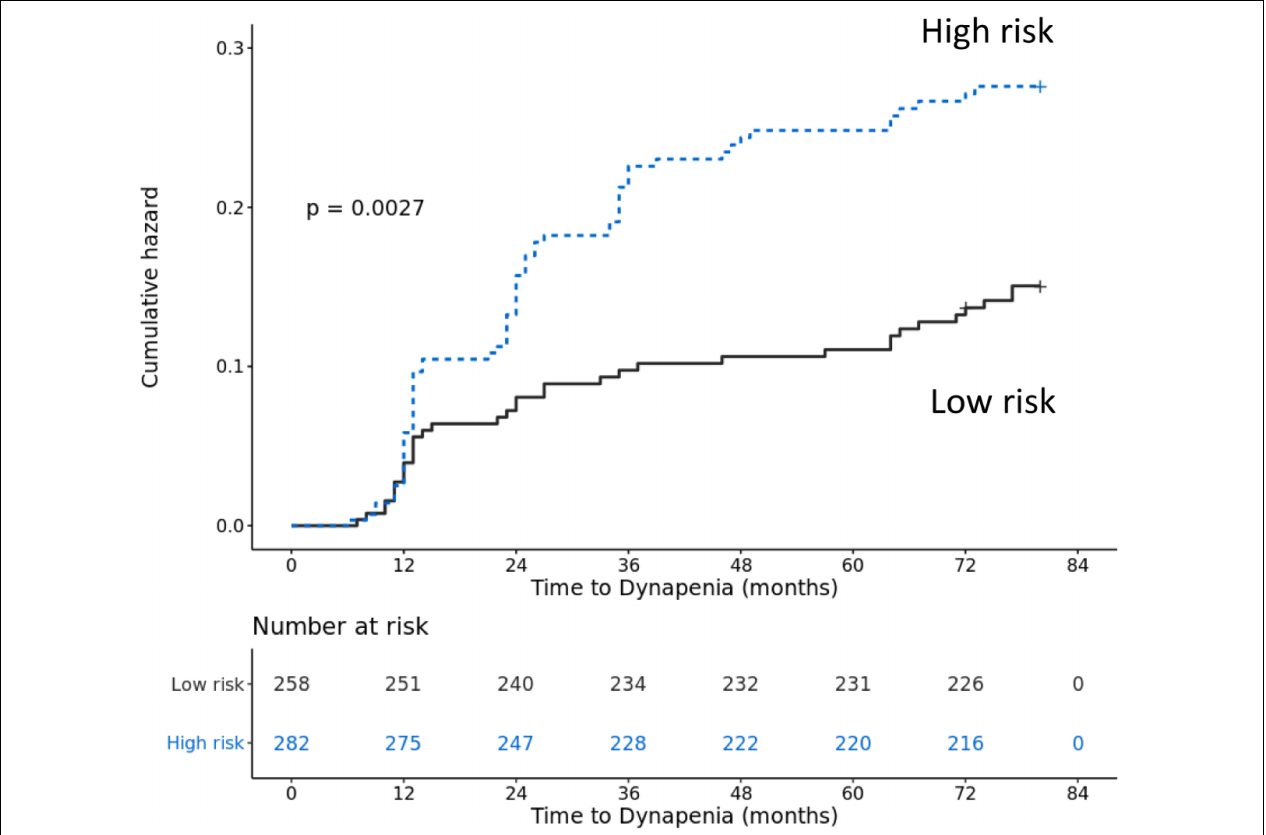
FIGURE 1 | Accumulative risk of transition to dynapenia from robust between participants with high risk factors and low risk factors.